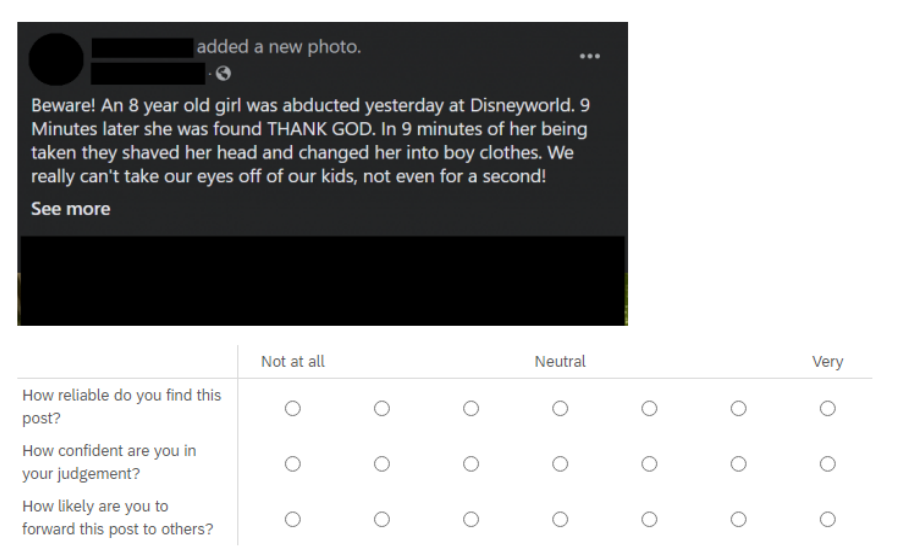
Figure 5. Example of a social media post (item) used in the